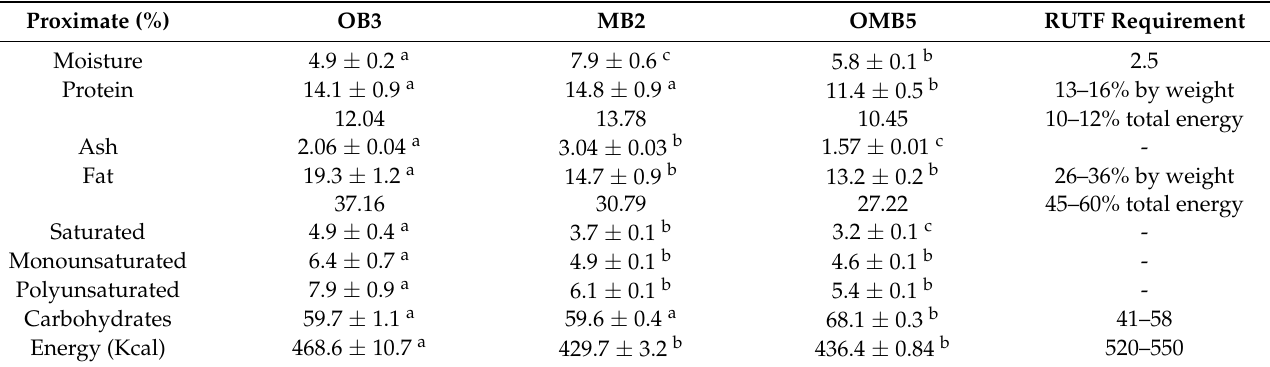
Table 9. Chemical composition (g/100 g) of BAMOnut bar (OM, MM, and